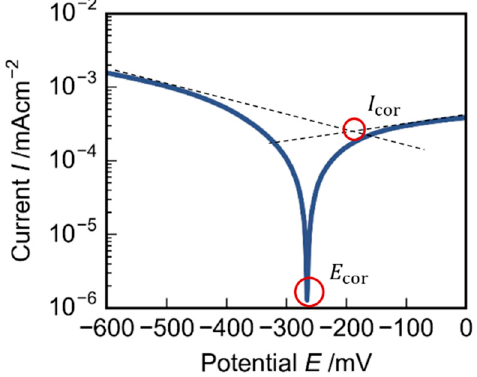
Figure 4. Linear Sweep Voltammetry (LSV) measurement in 0.1 M phosphate buffer with 0.1 M NaCl. Scan rate: 0.001 Vs − 1 . Corrosion current determined by the Tafel method and corrosion potential are marked.